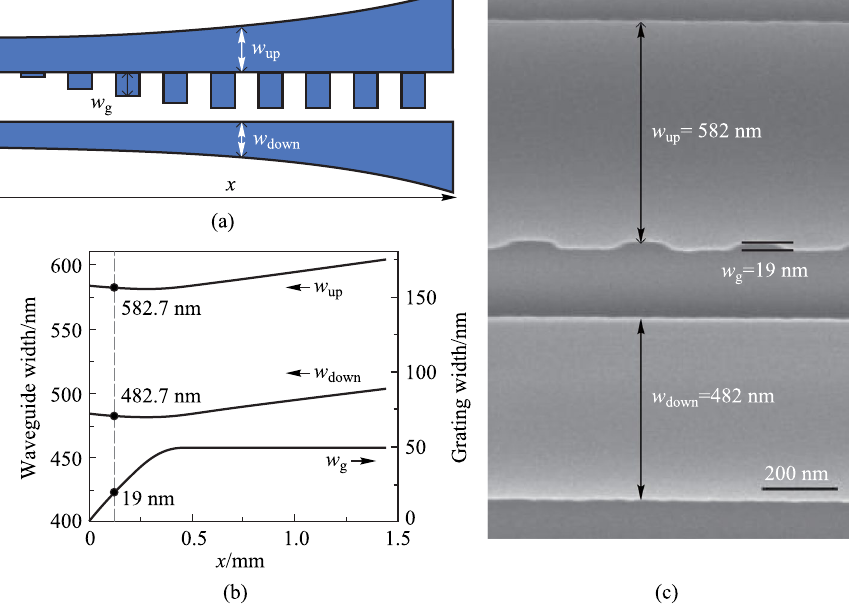
Fig. 3 Chirped Bragg gratings waveguide after width nonlinear correction: a schematic diagram, b variation of the simulated w and c SEM